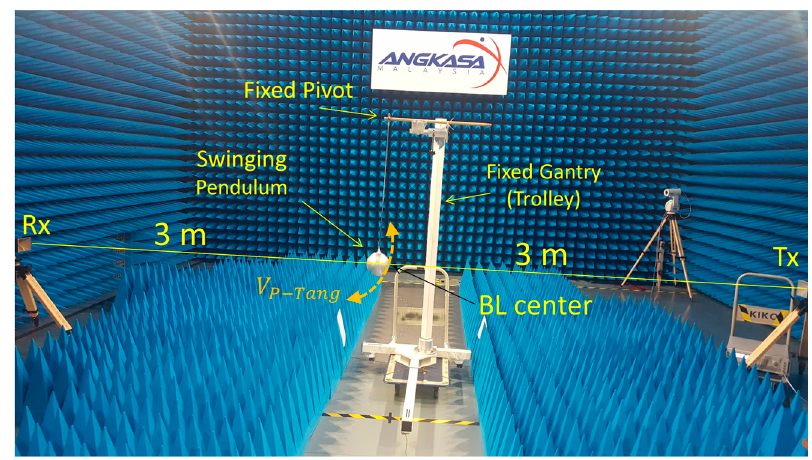
Figure 11. Scenario A configuration, one pendulum crossing the baseline.